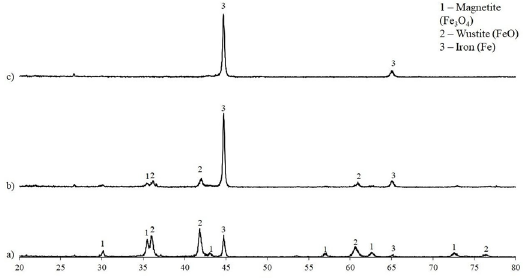
Figure 13. XRD spectra of the iron-ore pellets reduced in different isotherms: a) at the end of the 700 °C isotherm; b) at end of the 800 °C isotherm; and c) at the end of the reduction